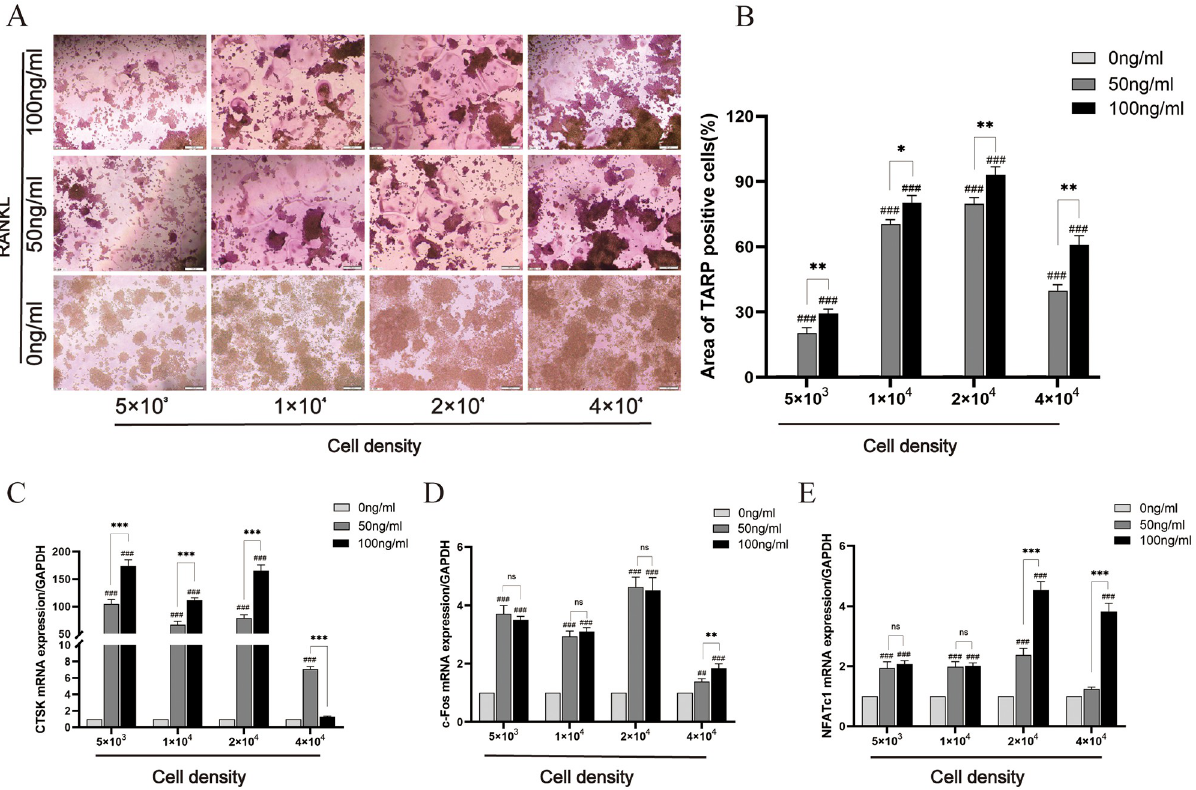
Fig 1. Effects of different concentrations of RANKL alone on osteoclast differentiation in RAW264.7 cells. RANKL (50 ng/ml and 100 ng/ml) induced differentiation of osteoclasts from RAW264.7 cells for 3 days or 5 days. (A) multinucleated osteoclasts were observed by light microscopy on day 5, original magnification of × 200 (Scale bar = 200 μ m). (B) TRAP-positive cells area was analyzed and quantified. The expressions of CTSK (C), c- Fos (D) and NFATc1 (E) were tested by qPCR on day 3. Data are presented as mean ± SD (n = 3). # P < 0.05, ## P < 0.01, ### P < 0.001 vs. 0ng/ml RANKL group; � P < 0.05, �� P < 0.01, ��� P < 0.001 vs. 50ng/ml RANKL group; ns, no